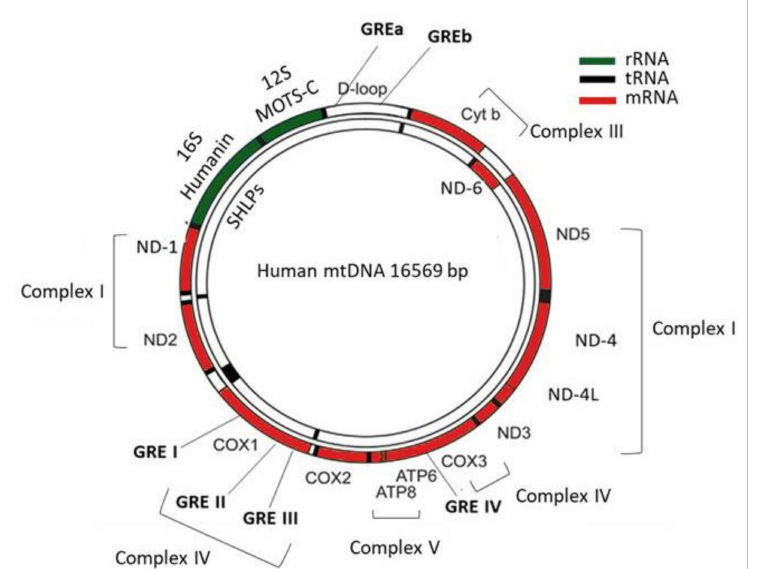
Figure 1. The human mitochondrial genome. The human mitochondrial genome consists of a circular, double-stranded DNA of 16.569 bp. It encodes two ribosomal RNAs (12S and 16S), 22 tRNAs, and 13 mitochondrial proteins involved in the respiratory complexes; ND1, ND2, ND3, ND4, ND4L, ND5, ND6 encode subunits of the complex I, COX1, COX2, COX3 of the complex IV, CYTB of the complex III, and ATP6, ATP8 of the complex V. Three mitochondrial GREs reside in COX1 gene, one in COX3 and two within the D-loop. MOTS-c is encoded by ORFs within 12S rRNA while Humanin and SHLPs by ORFs within 16S